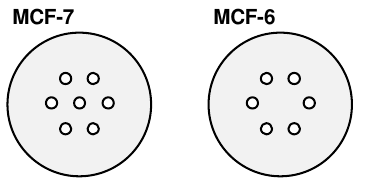
Figure 3. Tested fibers: MCF-7 and